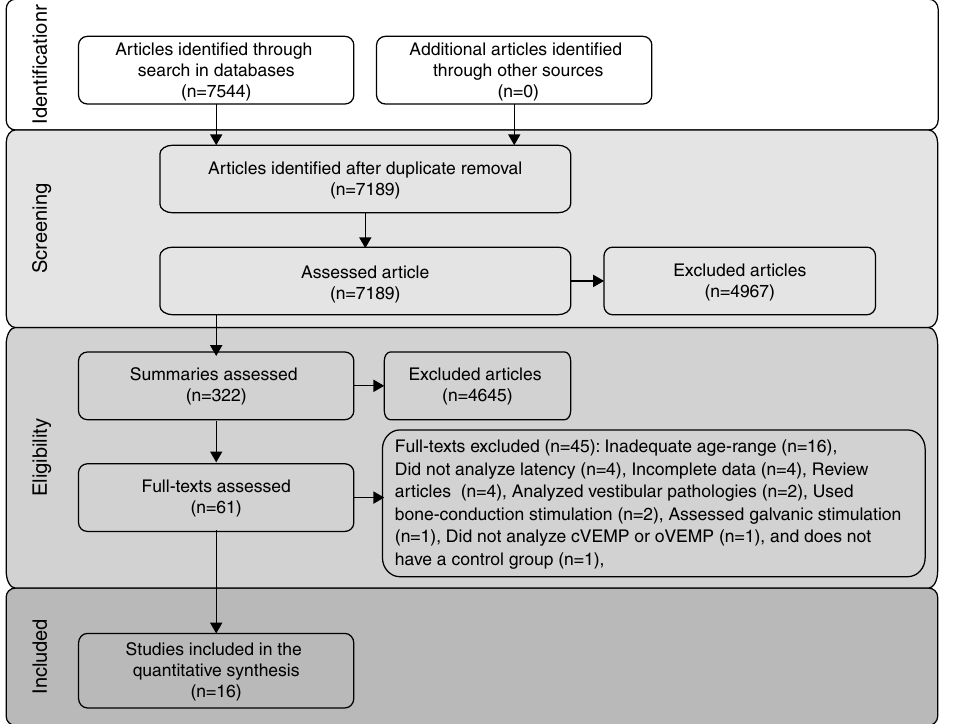
Figure 1 Flowchart of article search and